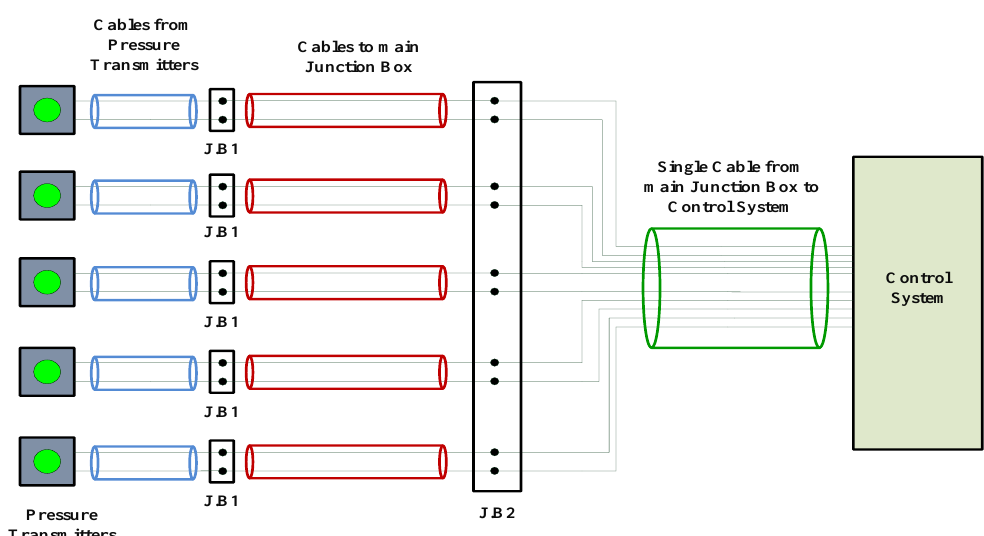
Figure 1. Connection diagram between 4 – 20 mA pressure transmitters and I/O modules in control system.